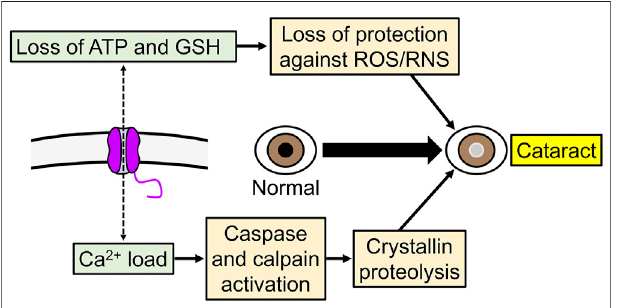
FIGURE 4 | Example of the role of increased Cx46 hemichannel activity in cataracts development. Abnormal increase in hemichannel activity can produce a variety of potentially deleterious effects in cells, including increases in Ca 2+ in fl ux, and ATP and glutathione (GSH) ef fl ux.